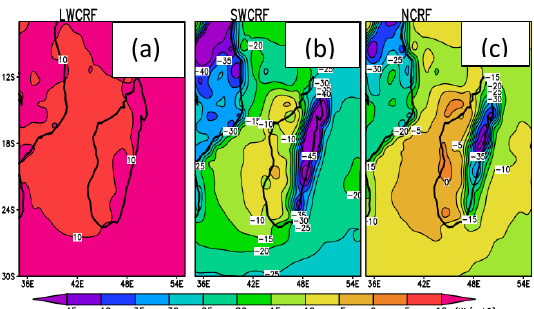
Figure 7. The 9-year (2000-2008) average (a) SWCRF